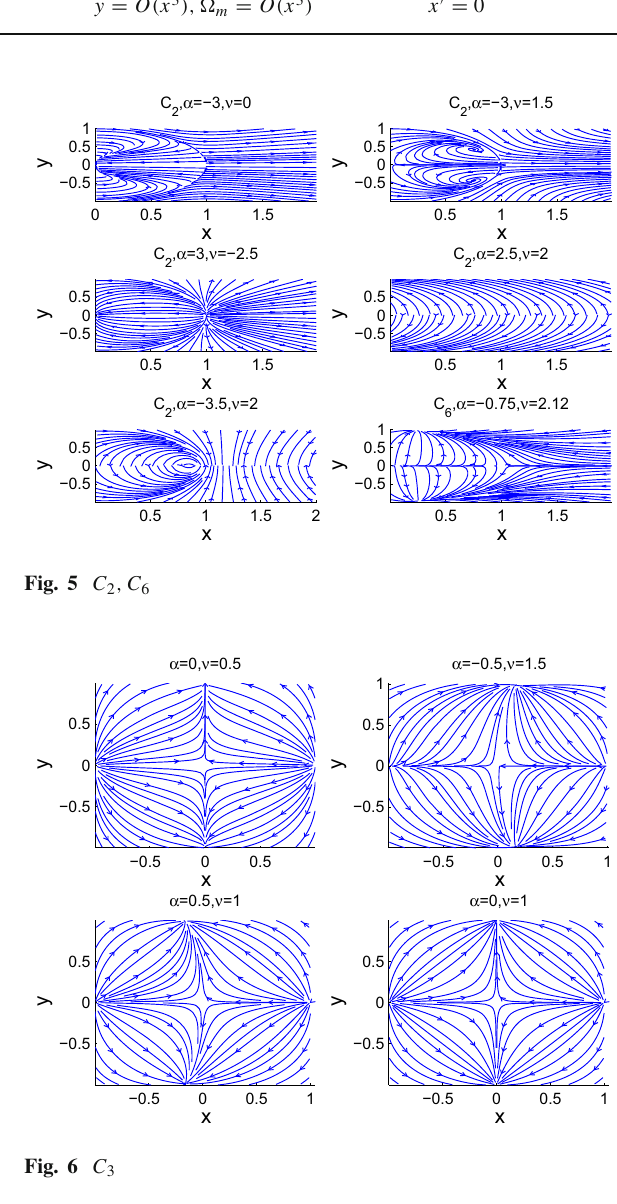
The equilibrium point C 1 is completely dominated by the baryonic matter and as expected in standard cosmology, the model will be in decelerating phase if the baryonic fluid is ) and it will be in the acceler- normal (ie, non-exotic: ν > 2 3 ating era for exotic nature of the matter (ie, ν < 2 3